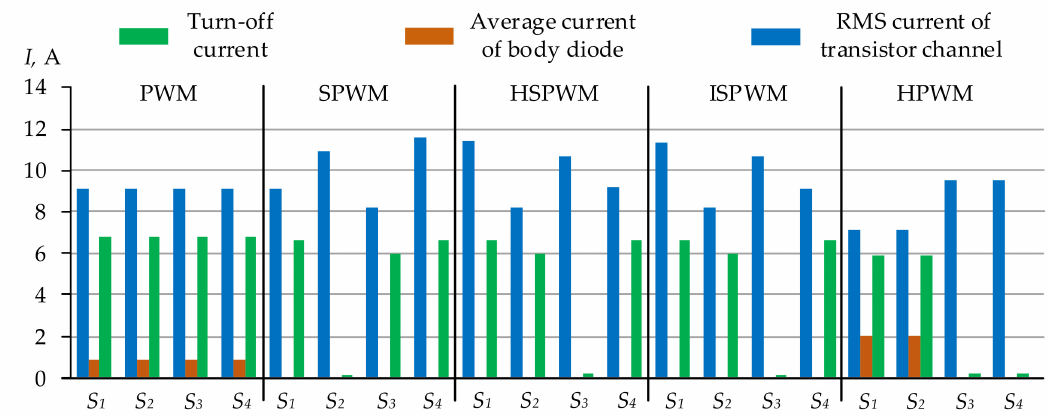
Figure 5. Diagram of current stresses of the switches at V in = 50 V, P = 200 W for di ff erent PWM